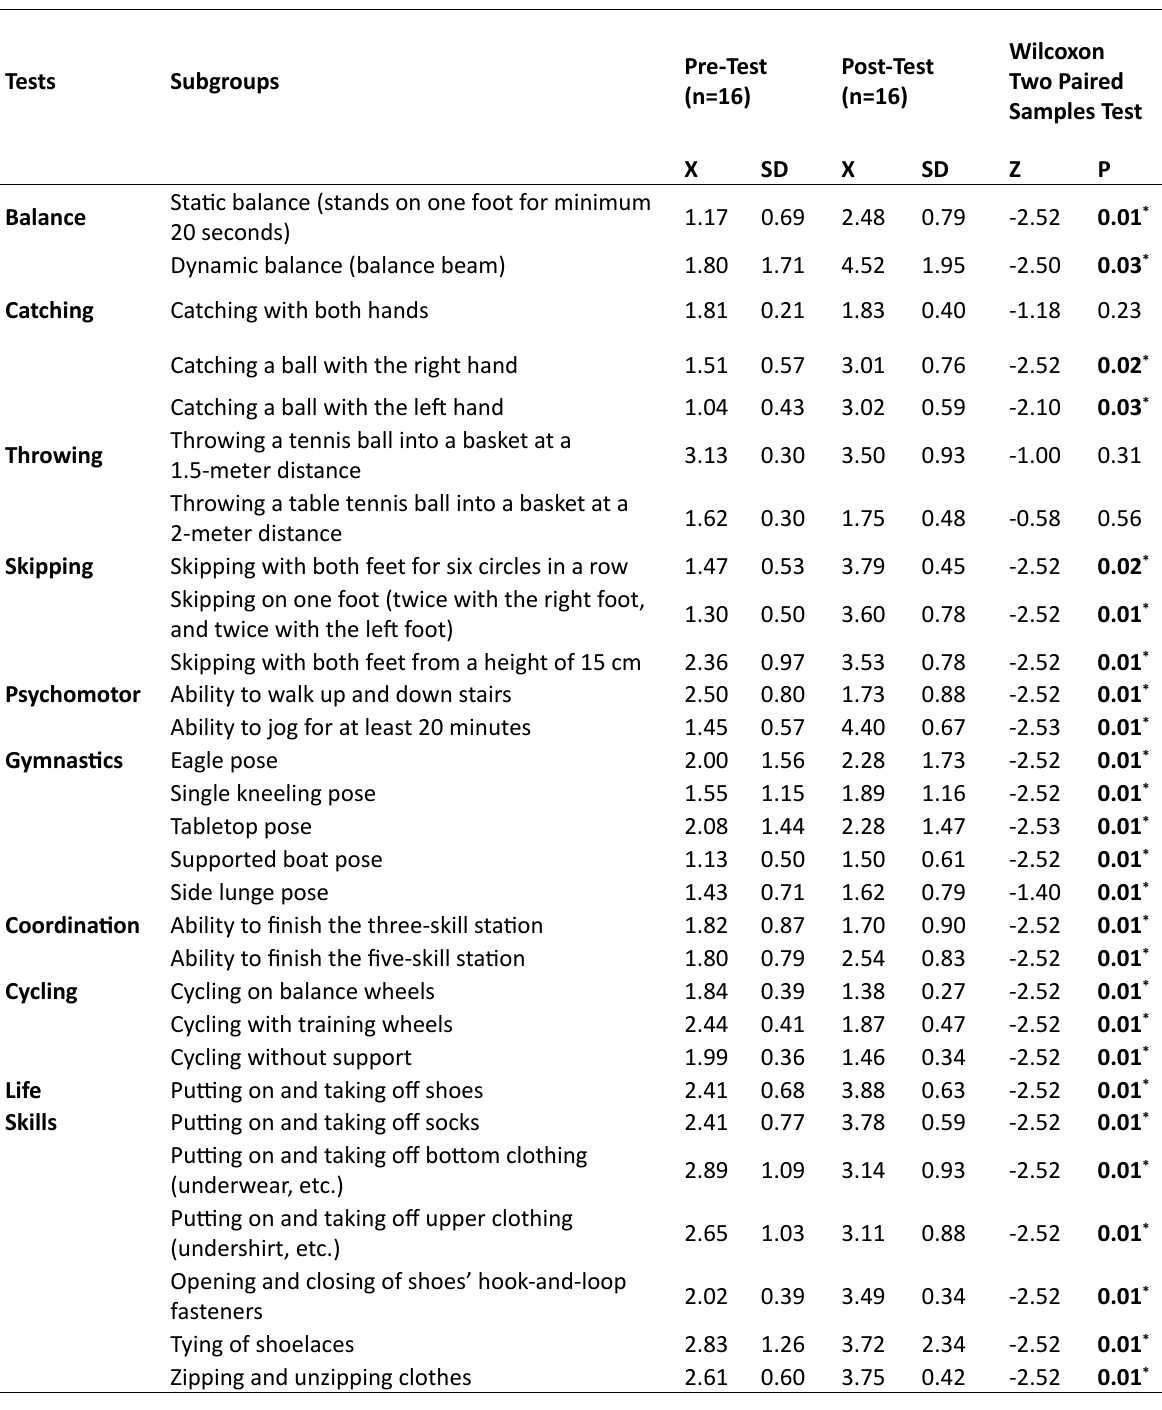
Table 2. Results of Pre and Post-Test in Children with Autism Spectrum